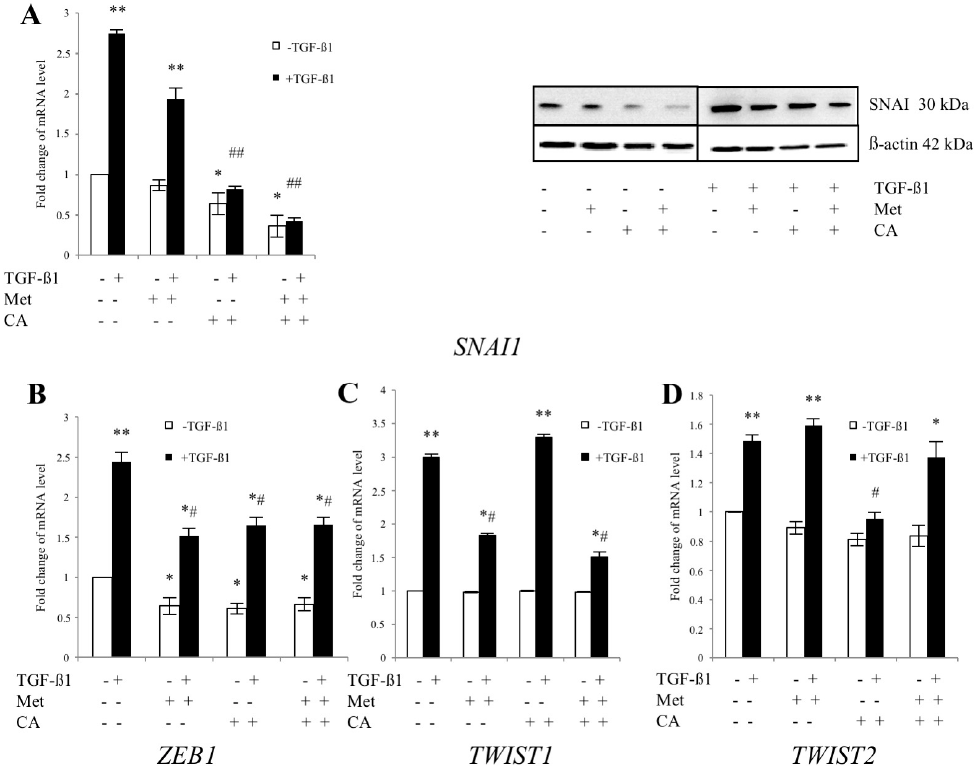
Figure 5. The effect of Caffeic Acid (CA) and Metformin (Met) on expression of transcription factors regulating EMT in C4-I cells. The cells were treated for 48 h with TGF- β 1 (10 ng/mL) plus CA (100 μ M) and/or Met (10 mM). In parallel, cultures of both cell lines were incubated with tested compounds, but without addition of TGF- β 1. Expression of critical EMT promoters SNAI ( A ), ZEB1 ( B ) ; TWIST1 ( C ) and TWIST2 ( D ) was evaluated at mRNA level by qPCR. For Snail1 protein levels were detected by western blot (( A ), right panel). Immunoblots were prepared following SDS-PAGE separation of cell lysates as described in Materials and Methods (20 μ g of total cell lysates were subjected to SDS-PAGE followed by immunoblotting and chemiluminescent detection, and β -actin was used as the protein loading control). In TGF- β 1-stimulated cells the expression (( A ), left panel) and protein amount (( A ), right panel) of SNAI was significantly downregulated by CA and CA/Met). Met downregulated TWIST-1 expression and CA decreased mRNA for TWIST2. The data were normalized against GAPDH transcript as a reference gene and levels of RNA expression were determined with the 2 −ΔΔ C t method (* p < 0.05 and ** p < 0.01 vs. control, # p < 0.05 and ## p < 0.01 vs. control with TGF- β 1). Bar graph is representative of the relative mean transcript abundance ± SD for three experiments. Results were presented from three independent experiments.